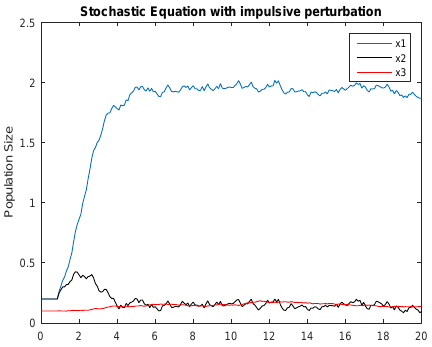
Figure 5. Increasing the intensity of white